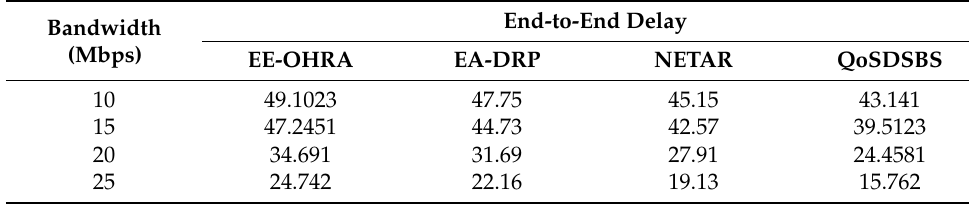
Figure 6. Bandwidth vs. end-to-end delay. Table 3. Results of bandwidth vs. end-to-end delay.